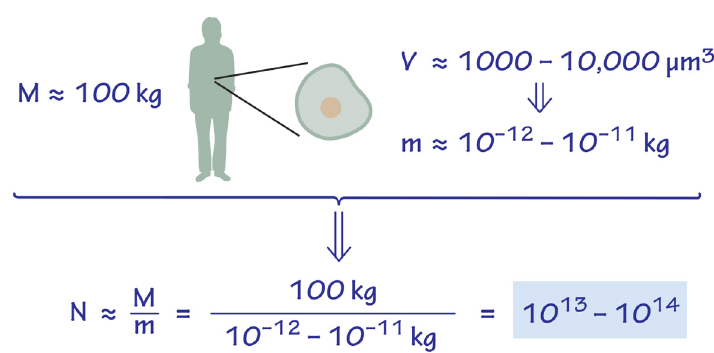
Fig 1. Back of the envelope estimate of the number of cells in an adult human body based on a characteristic volume and